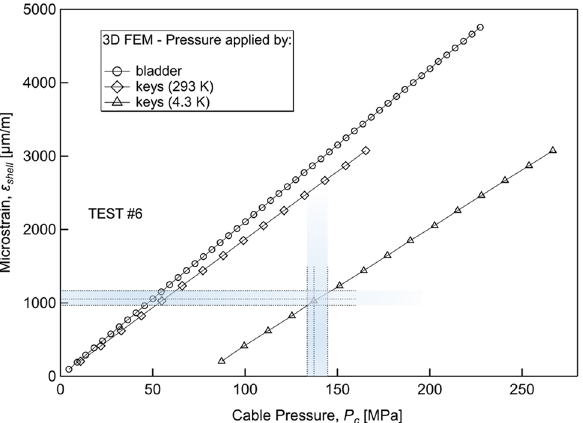
Figure 10. The relation between the azimuthal strain on the aluminium shell, evaluated at the positions depicted in Fig. 3, and the pressure on the 10-mm-wide cable calculated by the 3D FEM. The pressure was generated by a bladder (open circles) or by the interference between the keys and the Ti-6Al-4V components at 293 K (open diamonds) and at 4.3 K (open triangles). The procedure to assess the load on the cable is here resumed for Test #6. The measured strain averaged on the pair gauges SG1&3, SG2&4, and SG5&6 were 1050 μm/m, 970 μm/m, and 1160 μm/m, respectively. The pressure was estimated by using the highest measured strain (145 MPa), whereas the error was estimated as the difference between the maximum and minimum pressure values.